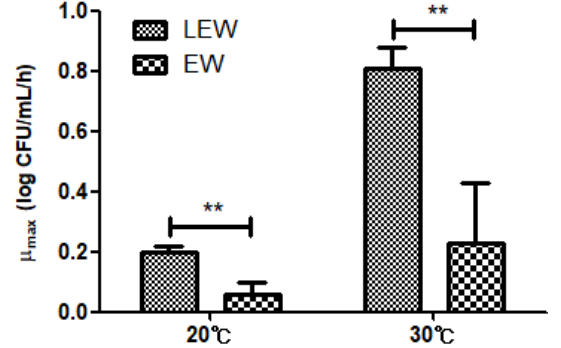
Figure 3. Specific growth rate for Salmonella spp. in LEW and EW stored at 20 and 30 ℃ . ** A significant difference between EW and LEW ( p < 0.01, t-test with IBM SPSS Statistics version 20).